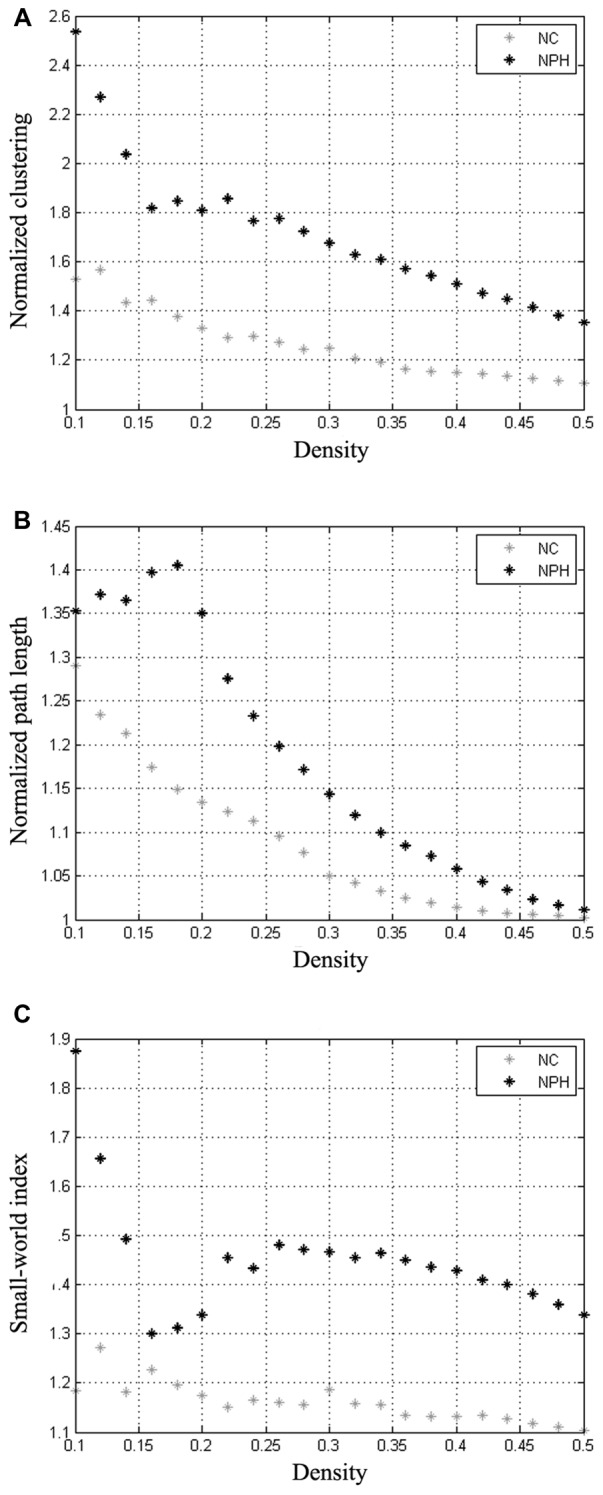
Changes in global network measures as a function of network density. Normalized clustering (A), normalized path length (B) and small-world index (C) of networks for the iNPH and NC groups. Networks from both the groups follow a small-world organization, with a normalized clustering of greater than 1 and a normalized path length close to 1. The small-world index is bigger than 1 on both networks across all the range of network density.